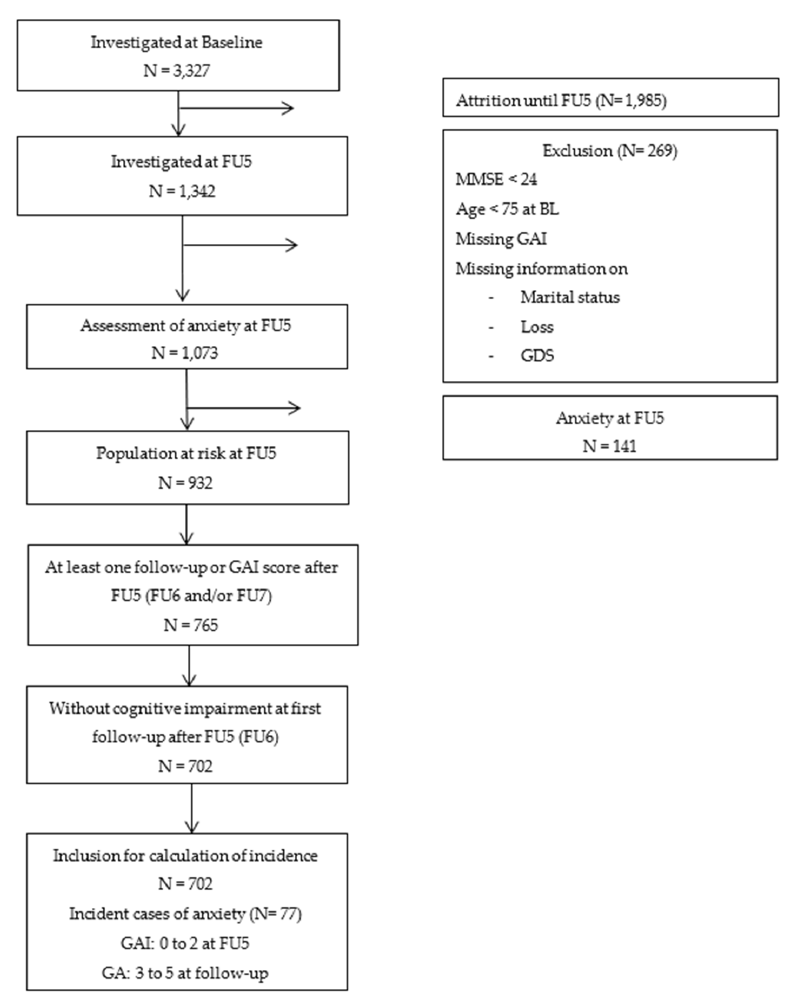
Figure 1. Flow chart for sample selection at baseline and